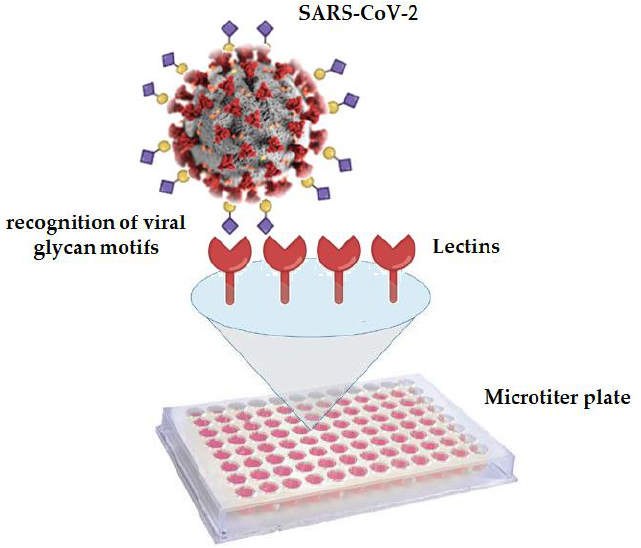
Figure 1. Schematic representation of GLYcoPROFILE ® technology. Recognition of SARS-CoV-2 glycan motifs by specific lectins immobilized on the microtiter plate.